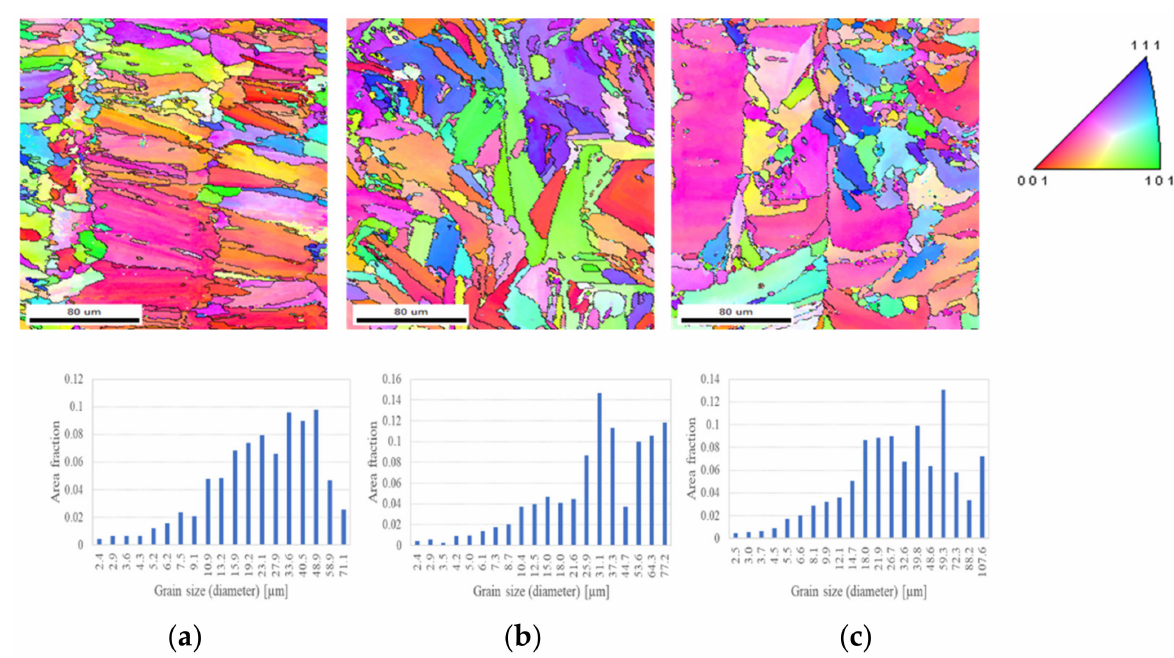
Figure 13. IPF maps and distribution of grain size of the xy section of tensile test specimens fabricated in the direction of